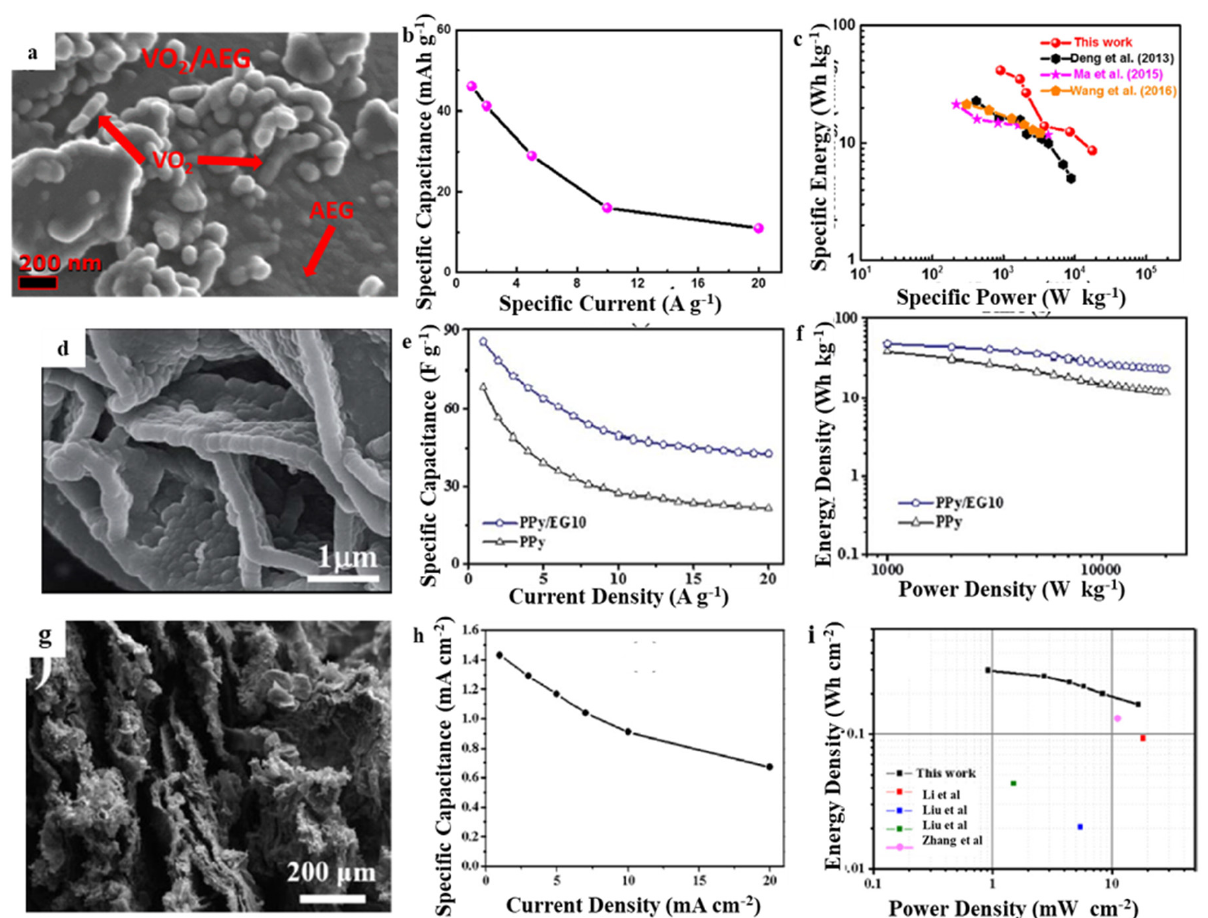
Figure 7. SEM of ( a ) VO 2 /AEG [64], ( d ) PPy/EG [65]; ( g ) EGP [31]; the specific capacitance of ( b ) VO 2 /AEG [64]; ( e ) PPy/EG [65]; ( h ) EGP [31] with various current densities; Ragone plots